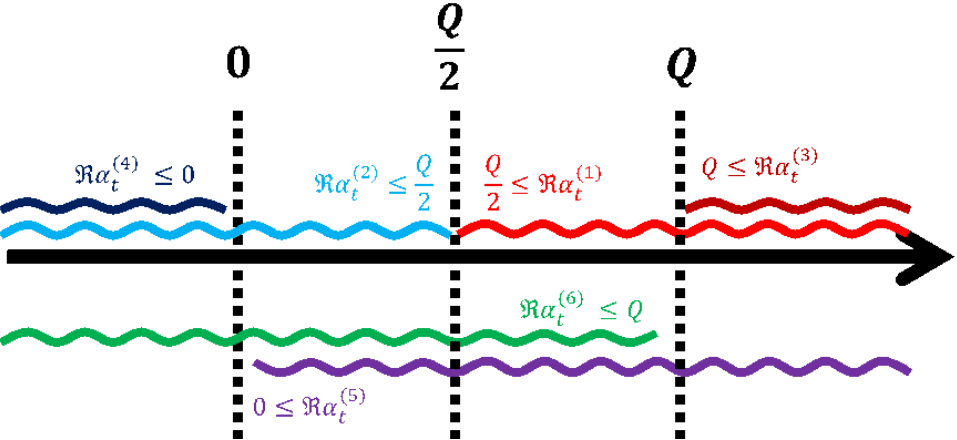
and (cid:11) (6) can cross t t